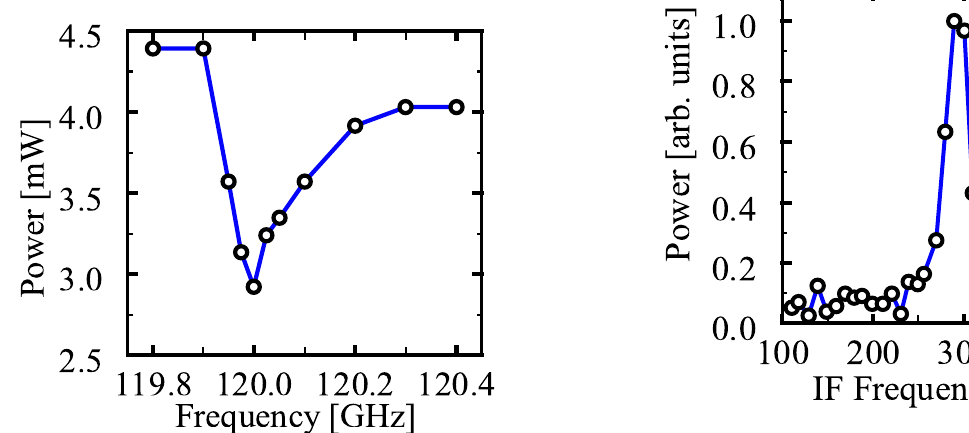
FIG. 5. (Color) Power measured by the diode as a function of the wave meter dial reading. The dip shown at 120 : 0 (cid:6) 0 : 025 GHz is consistent with the 7th harmonic of the rf frequency.